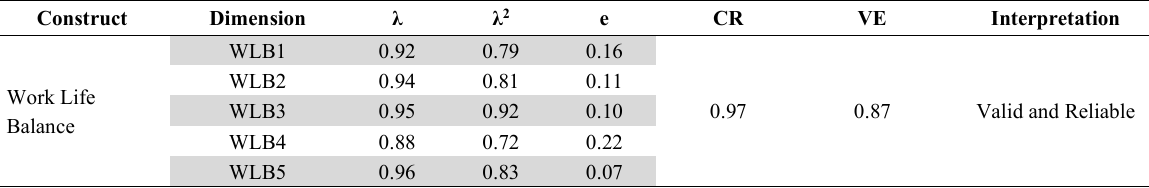
Validity and Reliability Tests on Work-Life Balance Construct